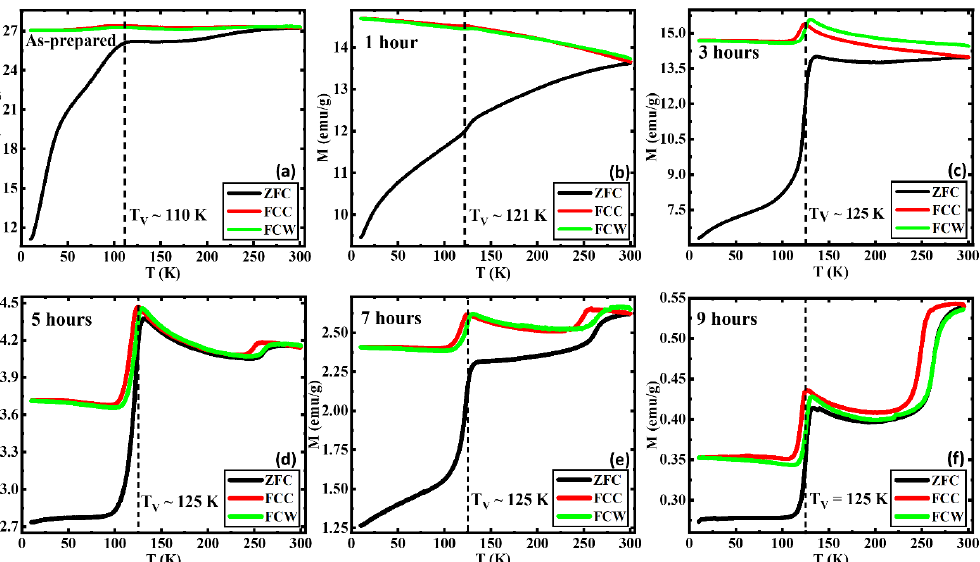
Figure 2. ZFC and FC M(T) curves in an applied field of 0.05 T for ( a ) as-prepared, ( b ) annealed for 1 h, ( c ) annealed for 3 h, ( d ) annealed for 5 h, ( e ) annealed for 7 h, and ( f ) annealed for 9 h iron oxide nanorods. For comparison, the M(T) data of ( a ) were taken from Ref.